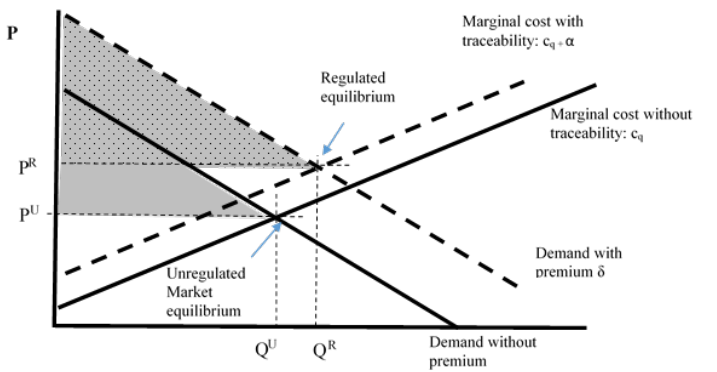
Figure 1. Equilibria in a closed economy.